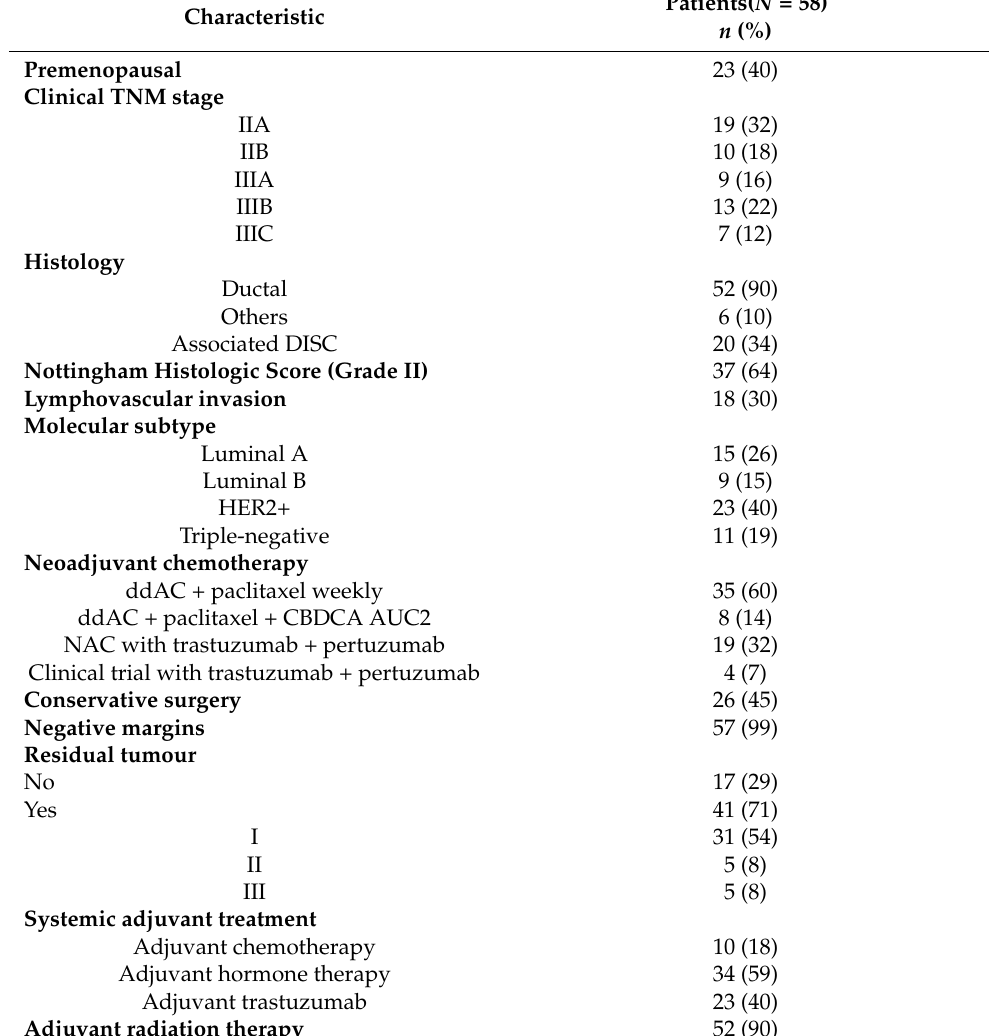
Table 1. Patient characteristics at baseline and treatment